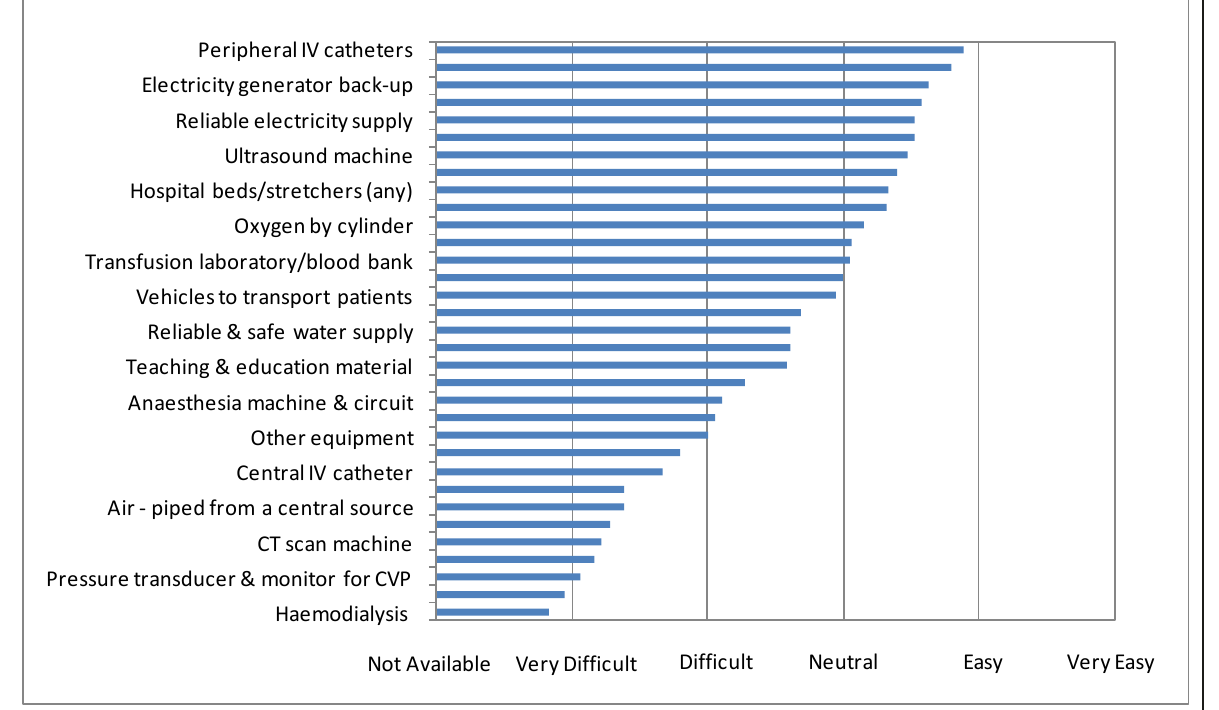
CVP = Central venous pressure. CT = Computed tomography. IV = intravenous. Figure 3 Ease of accessibility to equipment